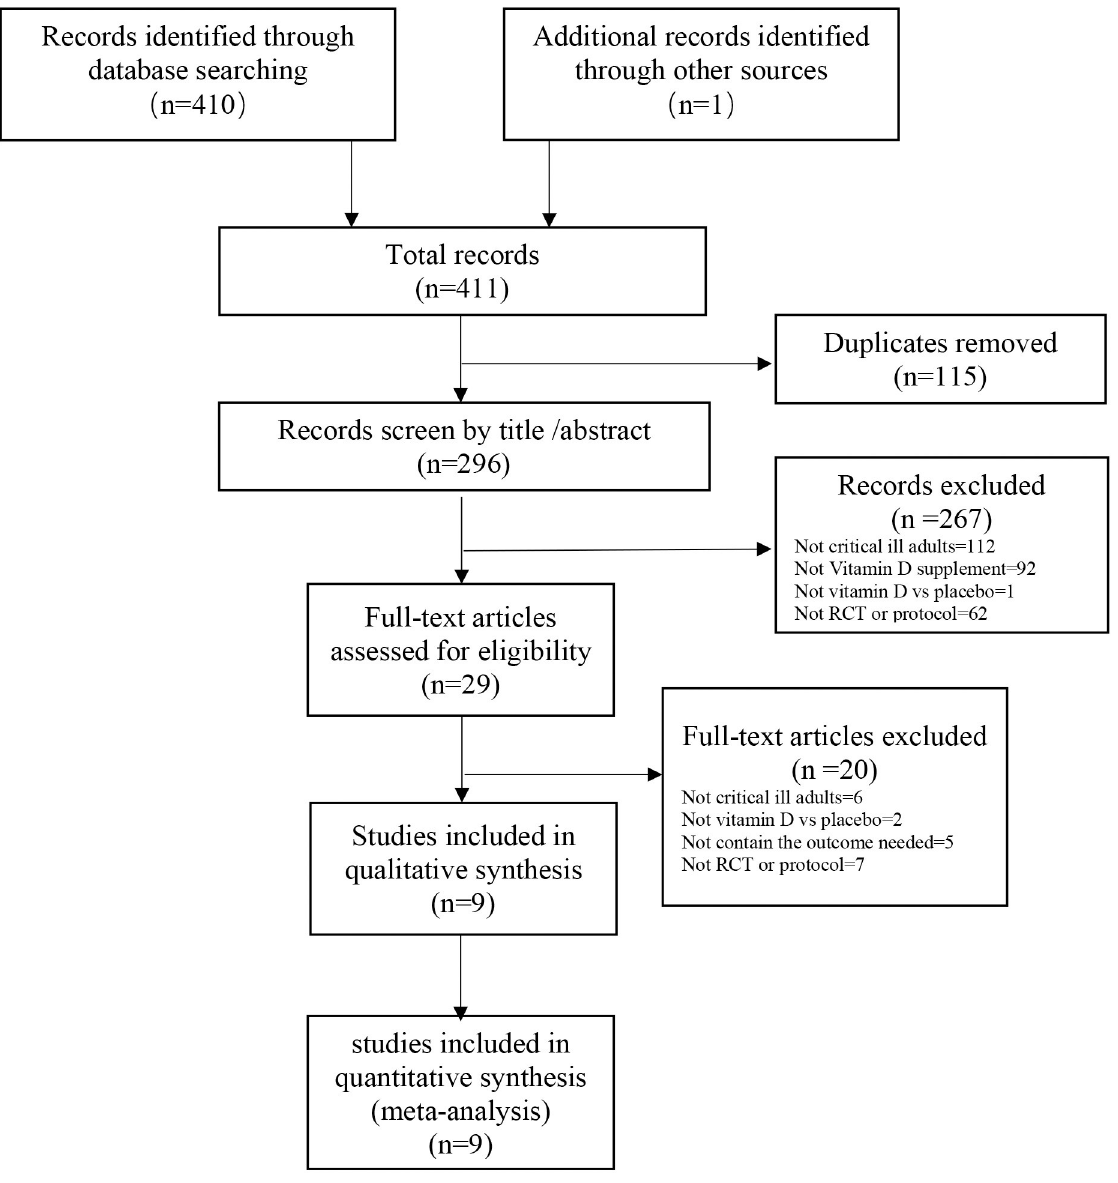
Fig 1. Search strategy and final included and excluded